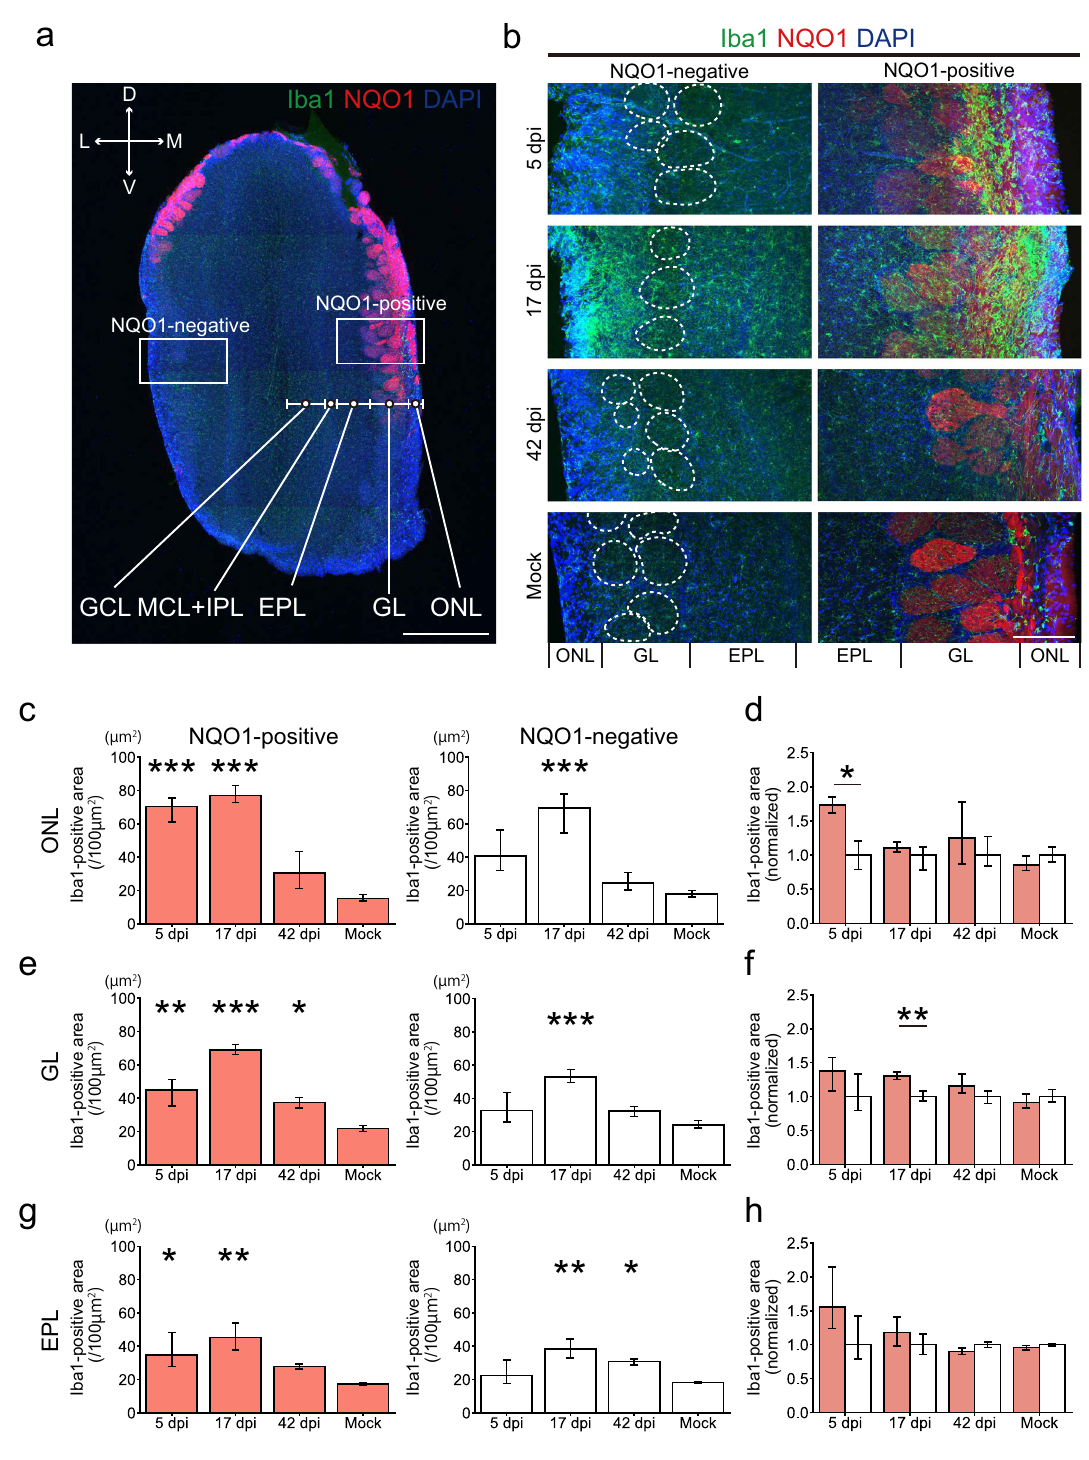
Figure 6. Region-specific microglial activation in the OB due to SARS-CoV-2 infection. (a) Representative coronal section of the OB stained with Iba1, NQO1, and DAPI. The OB has a multi-layered structure from surface to the center; Olfactory nerve layer (ONL), Glomerular layer (GL), External plexiform layer (EPL), Mitral cell layer (MCL), Internal plexiform layer (IPL), and Granule cell layer (GNL). Squares are representative regions in the analysis of NQO1-positive and -negative region. Scale bar, 1 mm. (b) Representative images of ONL, GL, and EPL stained with Iba1, NQO1, and DAPI. White dashed circles indicate glomeruli. Scale bar, 200 μm. (c,e,g) , Iba-1-positive area in the ONL (c) , GL (e) , and EPL (g) . (n = 3, one-way ANOVA followed by Dunnett’s post hoc test. *p < 0.05, **p < 0.01, ***p < 0.001). (d,f,h) Comparison of the normalized values of the Iba1-positive area in NQO1-positive and NQO1-negative regions in the ONL (d) , GL (f) , and EPL (h) . (n = 3, Welch’s t-test. *p < 0.05, **p <